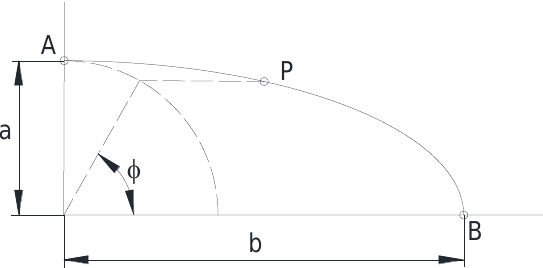
Figure 5. Characterization of a crack front point P through the angle ϕ .